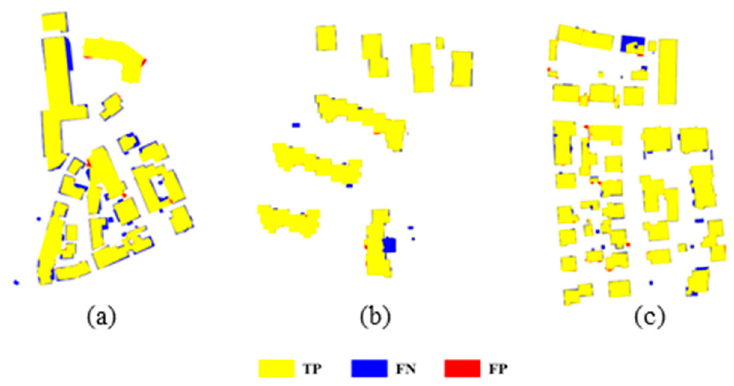
Figure 8. Semantic labeling results and visualized evaluation of three Vaihingen test sites. ( a ) vs. Area 1, ( b ) vs. Area 2, and ( c ) vs. Area 3.